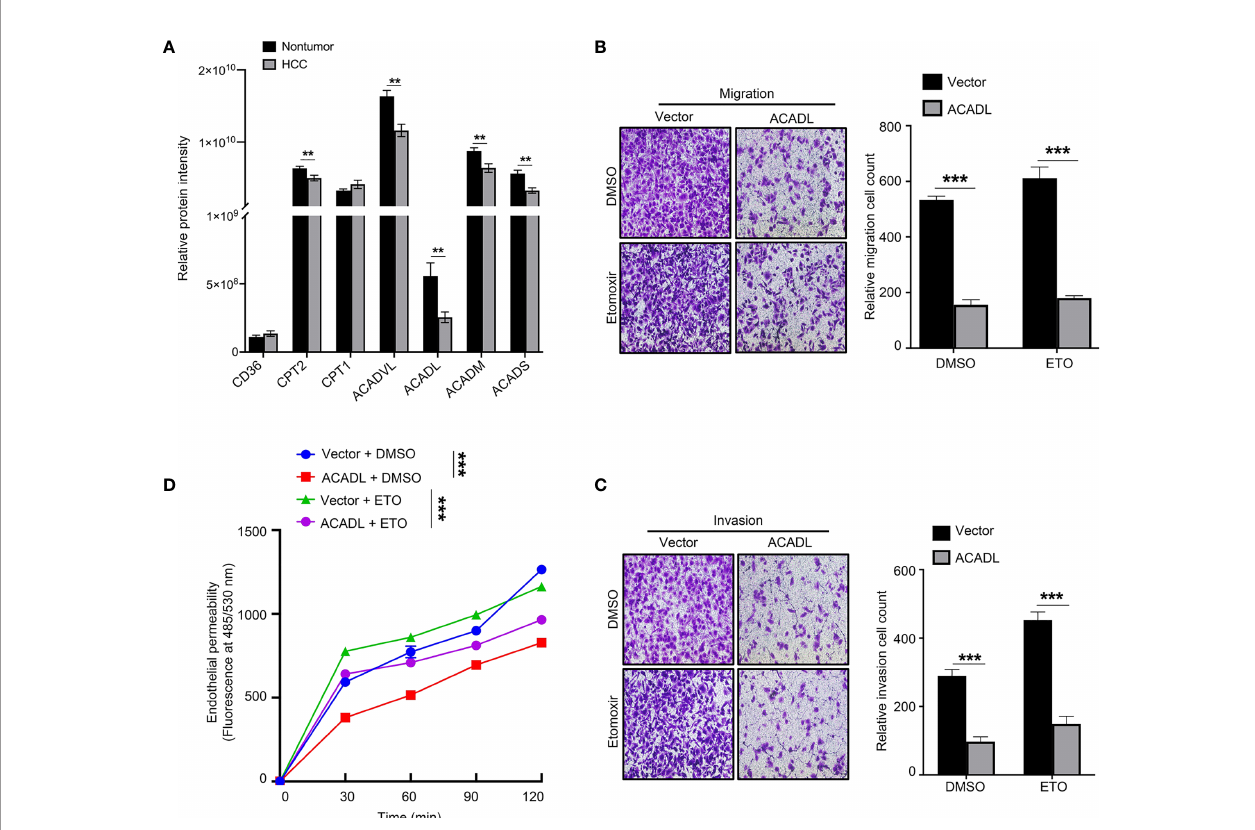
FIGURE 4 | Blockage of FAO does not affect the inhibitory effect of ACADL on HCC cell metastasis. (A) The expression of FAO pathway related proteins in HCC and adjacent nontumor tissues. (B, C) Transwell of MHCC97H cells overexpressing ACADL or those in control cells treated with etomoxir (50 m M) or DMSO. Original magni fi cation, 200×. (D) Permeability of HUVEC monolayers was analyzed by measuring the fl uorescence of diffused FITC-dextran (70 kDa) across the Transwell membrane for the indicated time (mean ± SEM, n = 6, paired t test). **P < 0.01, and ***P < 0.001 compared with